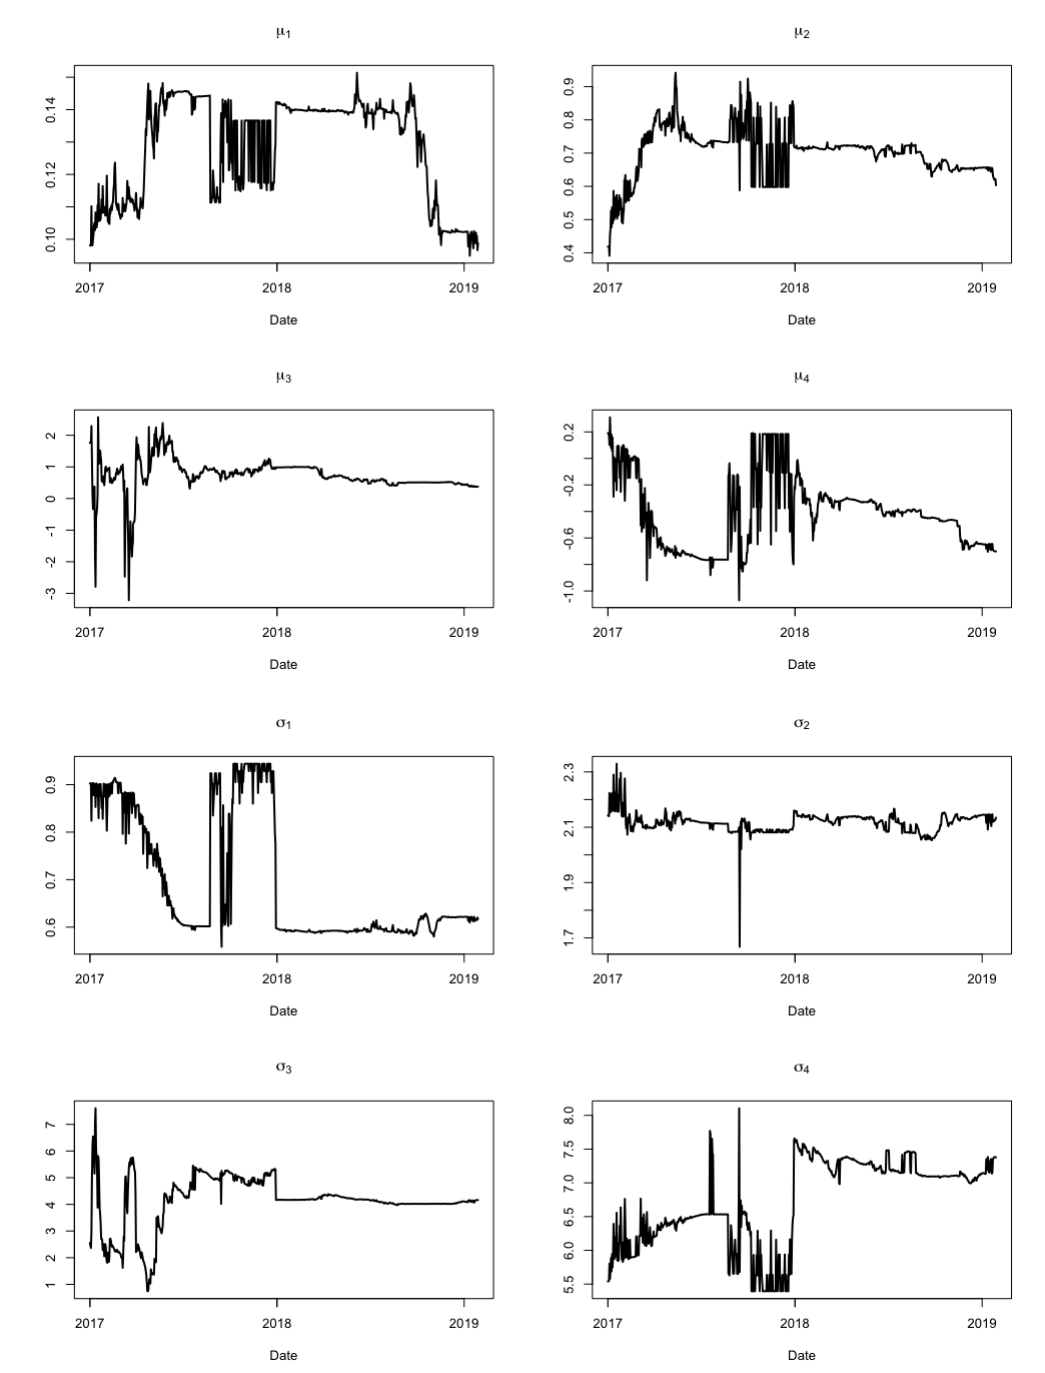
Figure 7. Expanding window: state-dependent means and volatilities for the homogeneous four-state normal HSMM on BTC/USD daily log